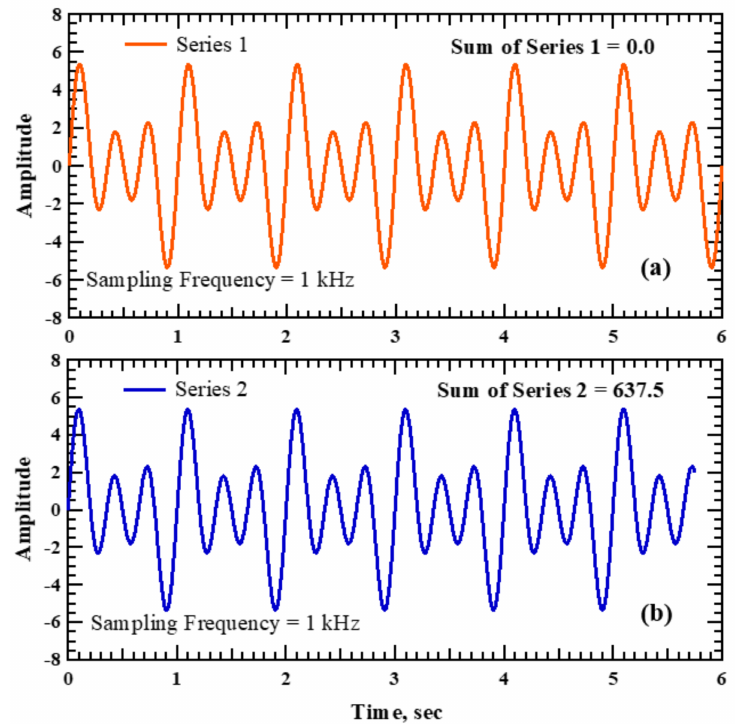
Figure 6. Algebraic sums of ( a ) Series 1 and ( b ) Series